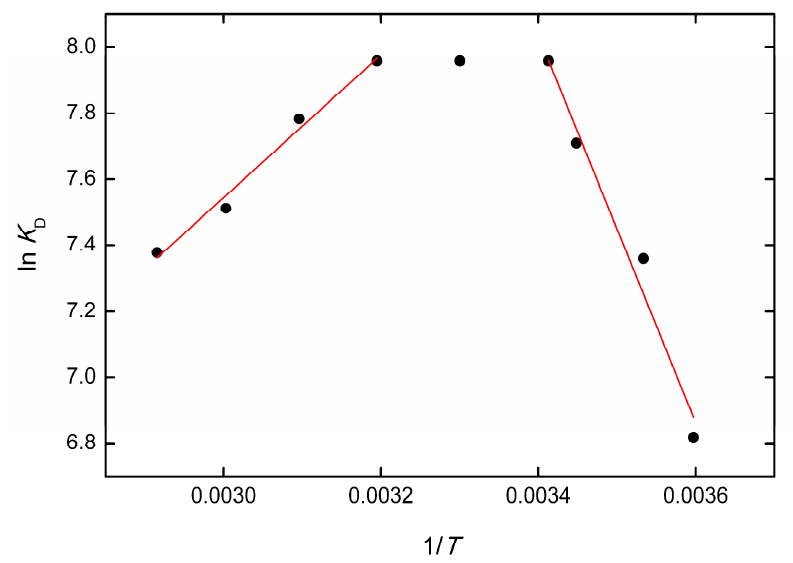
Figure 9. Van’t Hoff plot of ln ( K D ) vs. 1/ T for the adsorption of nitrates to Fe 3 O 4 @AgNPs at pH = 5, for C e = 10 mg L − 1 and 250 µ L of adsorbent. The graph reveals a change from endothermic to exothermic process as T increases, separated by a central region showing no dependence on T . Solid lines are theoretical fits given by Equation (8).